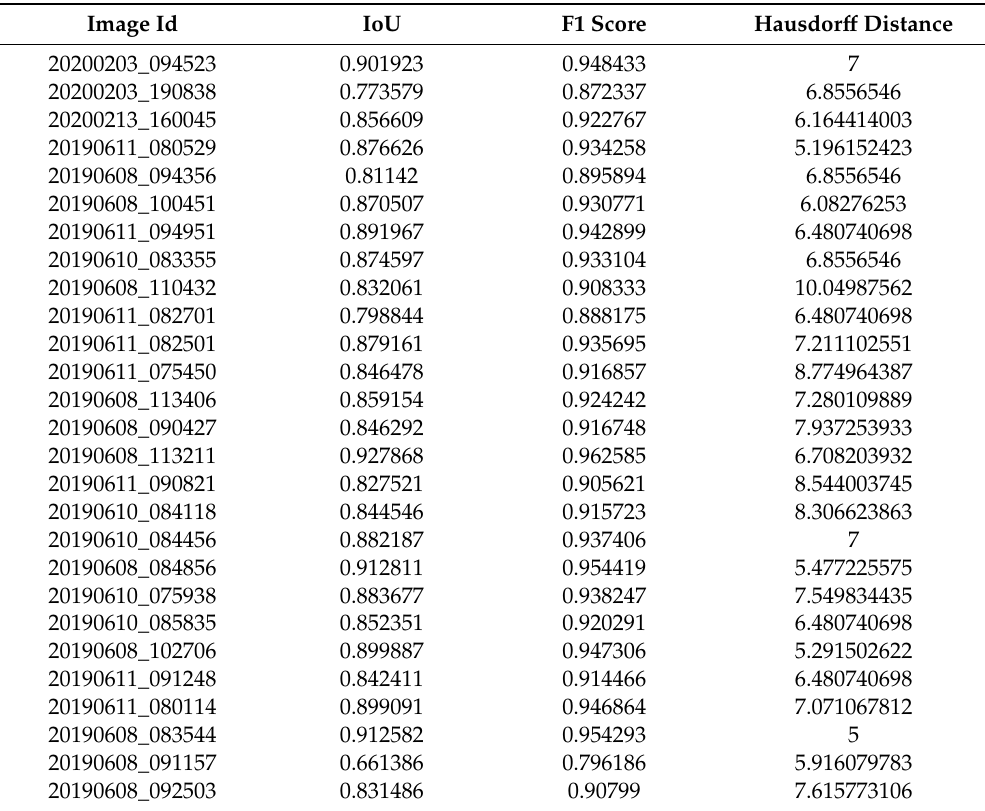
Table A1. Each sample from the test set underwent a calculation of the segmentation metrics proposed in this research with respect to the ground truth manually segmented